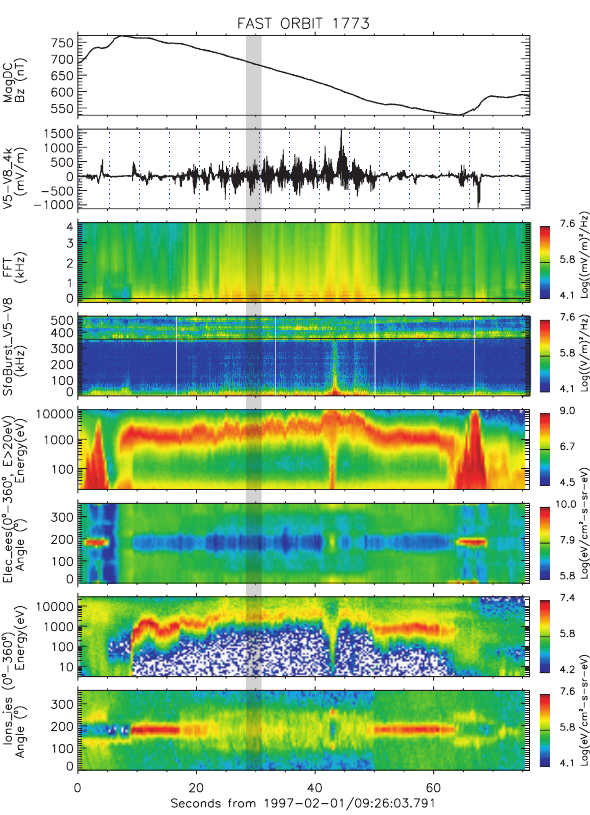
Fig. 3. A FAST spacecraft passage across the auroral kilometric radiation source region showing from top to bottom the magnetic component B z with its typical sheet current slope; the highly vari- able low-frequency electric wave amplitude reaching amplitudes of | δE | & ± 0 . 5Vm − 1 ; low frequency f < 4kHz broadband elec- tric field emissions typical for electron holes when exceeding the plasma frequency f e = ω e / 2 π . 2kHz; three cyclotron harmonic emissions in the AKR spectrum above the electron cyclotron fre- quency (black horizontal); the spectral electron energy density; an- gular distribution of electron fluxes; ion spectral energy density; and the ion angular distribution. The shaded slice is shown in highest resolution in the following figures (data obtained within the French- UCBerkeley